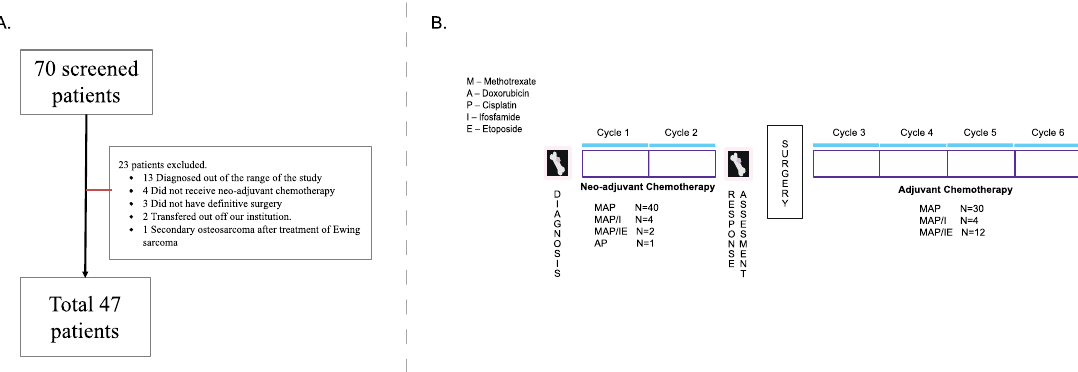
Figure 1. ( A ) Flow of patients during the study. ( B ) General treatment